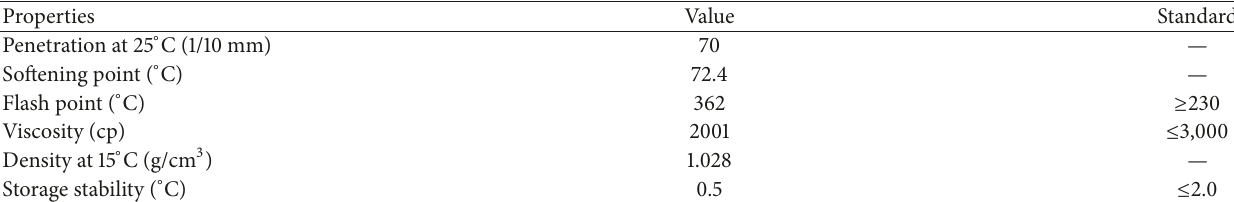
Table 3: Characteristics of polymer modified asphalt